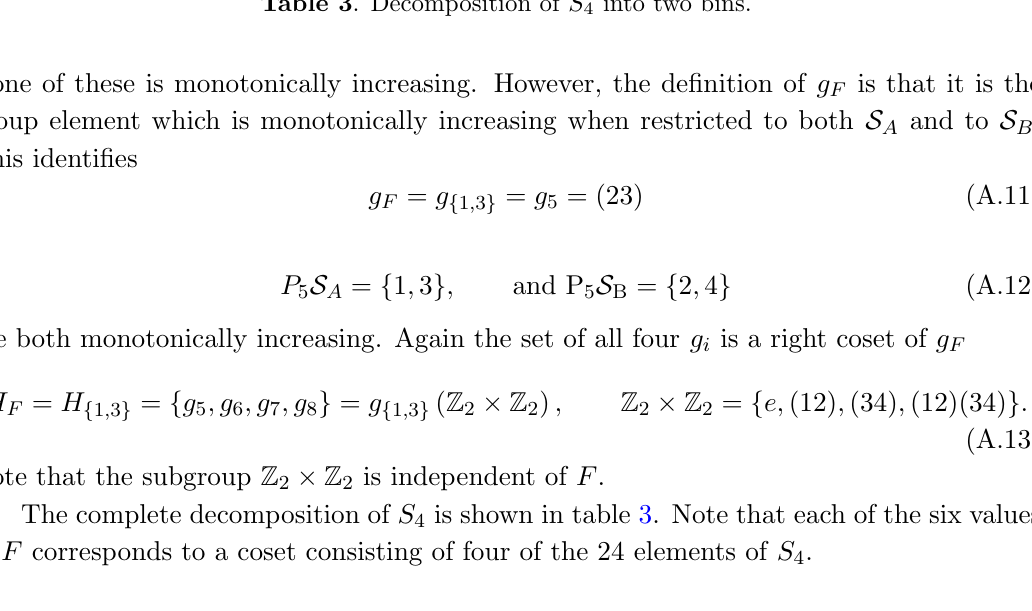
Table 3 . Decomposition of S 4 into two